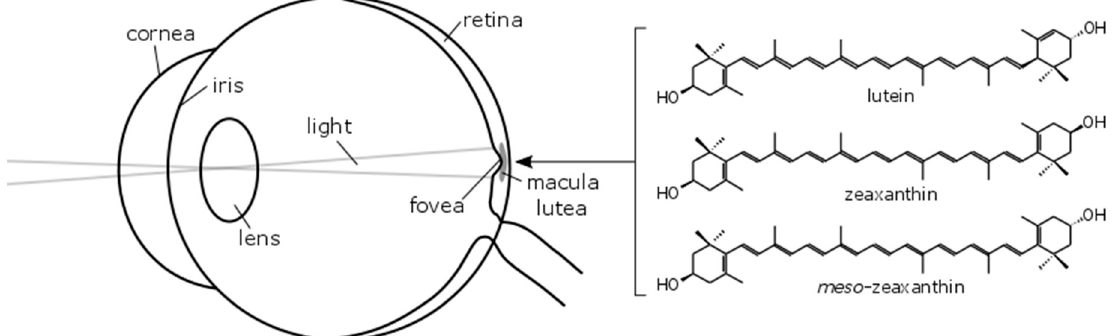
Figure 1. Schematic of the human eye showing the approximate location of the macular pigments and the chemical structure of the carotenoids which comprise macular